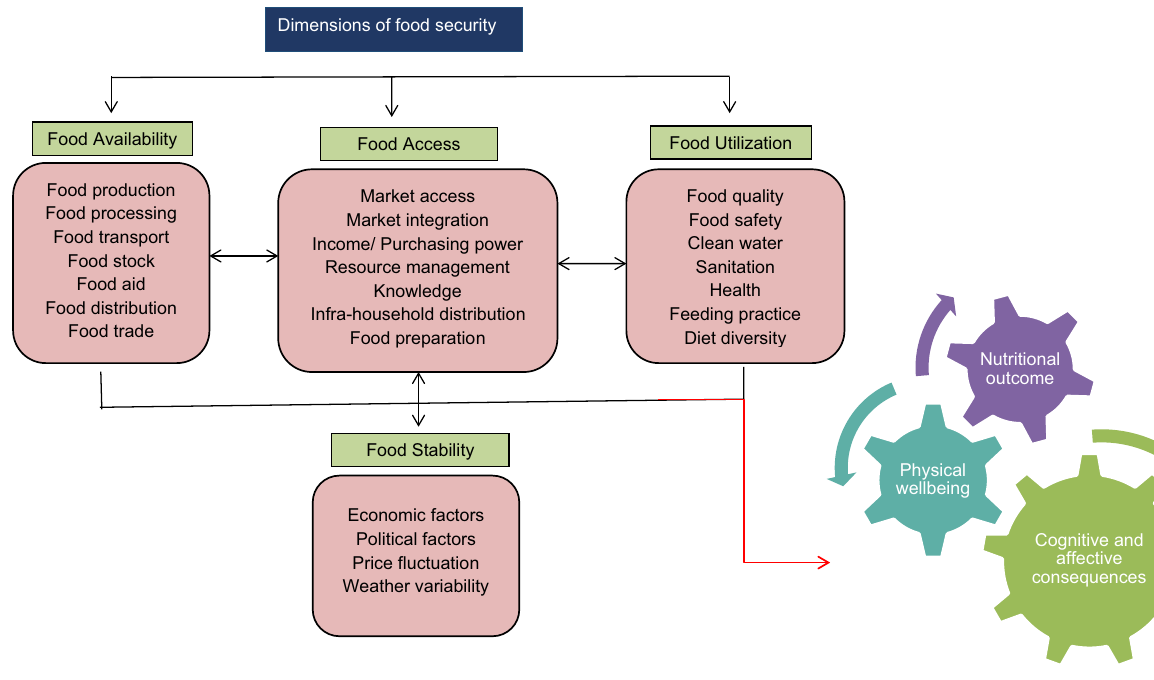
Fig. 2 Dynamics of food security and nutrition. Source: [16, 65]